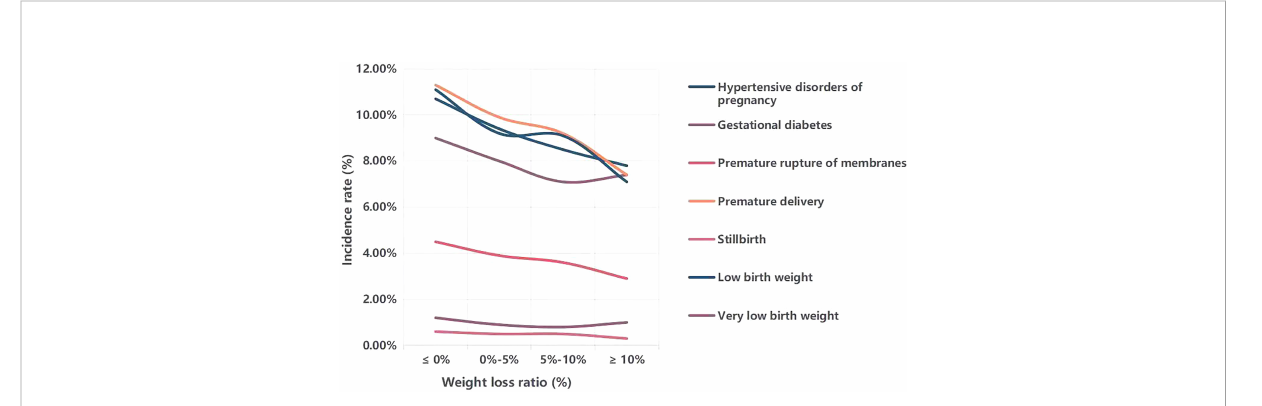
FIGURE 1 Comparison of the incidence of perinatal outcomes with different weight loss ratio. Weight loss ratio, (initial weight-weight at ovulation induction)/initial weight*100%.